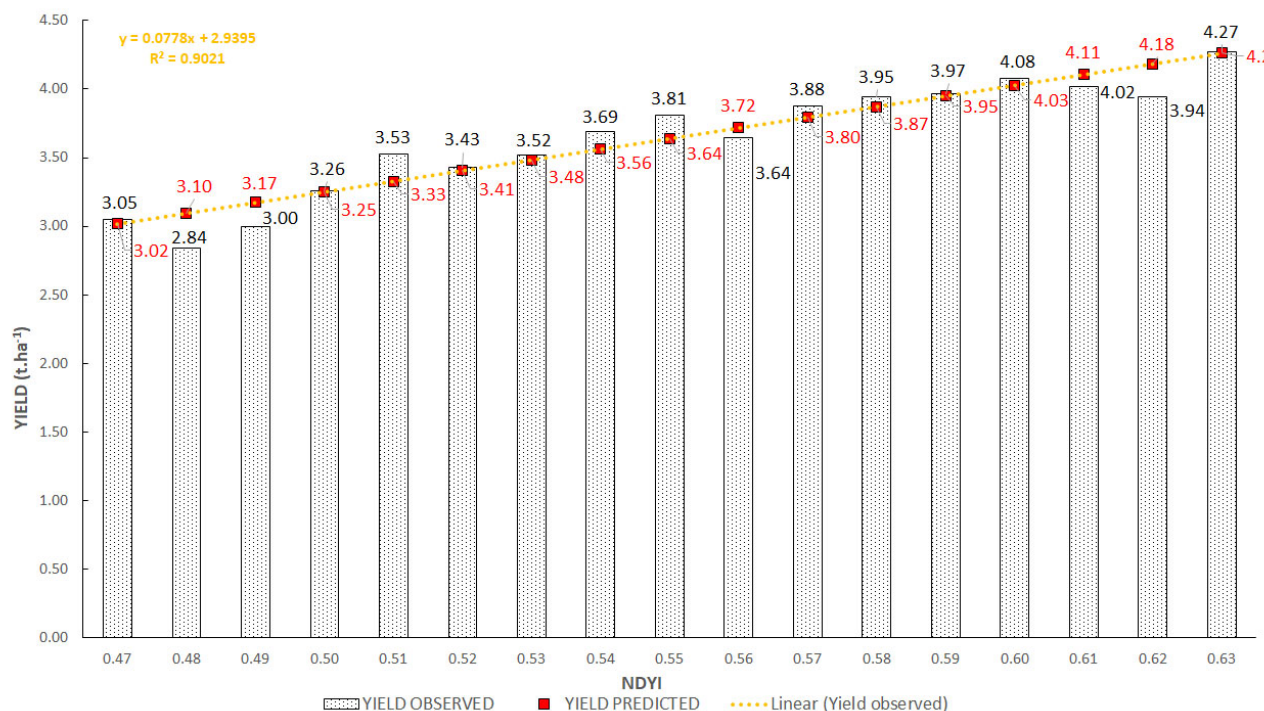
Figure 12. Graph of linear dependence of yield on BNDVI. Model shows yields observed and yields predicted based on the regression analysis of NDVI and yields achieved.